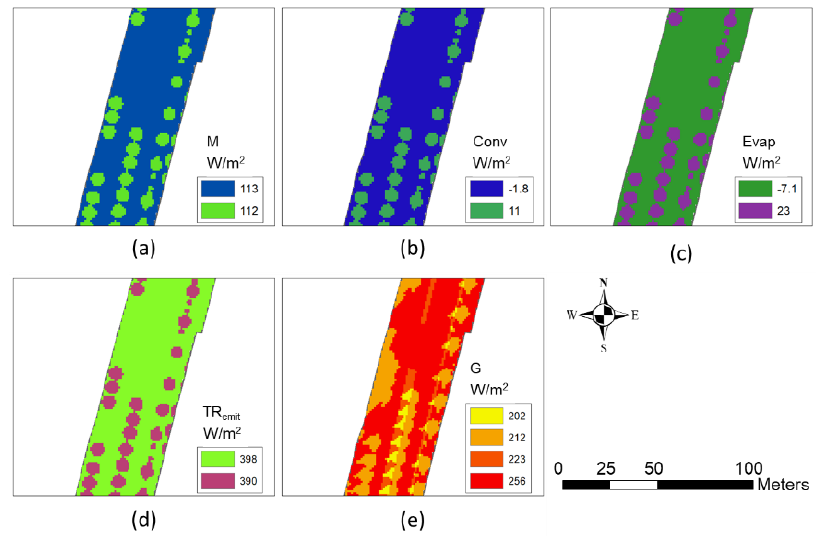
Figure 9. Results due to temperature adjustment for sunlit/shaded ground cover and surface objects, and under tree canopy at 1 p.m. for ( a ) M ; ( b ) Conv ; ( c ) Evap ; ( d ) TR emit ; and ( e ) G .